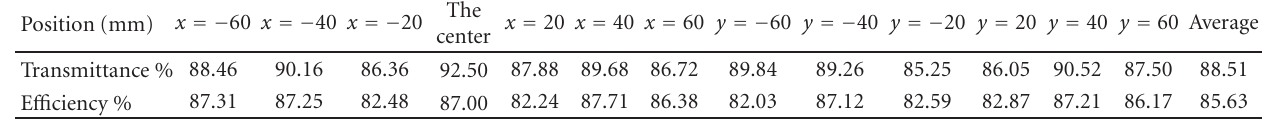
Table 3: The measured transmittance and the concentration e ffi ciency of the concentration system.